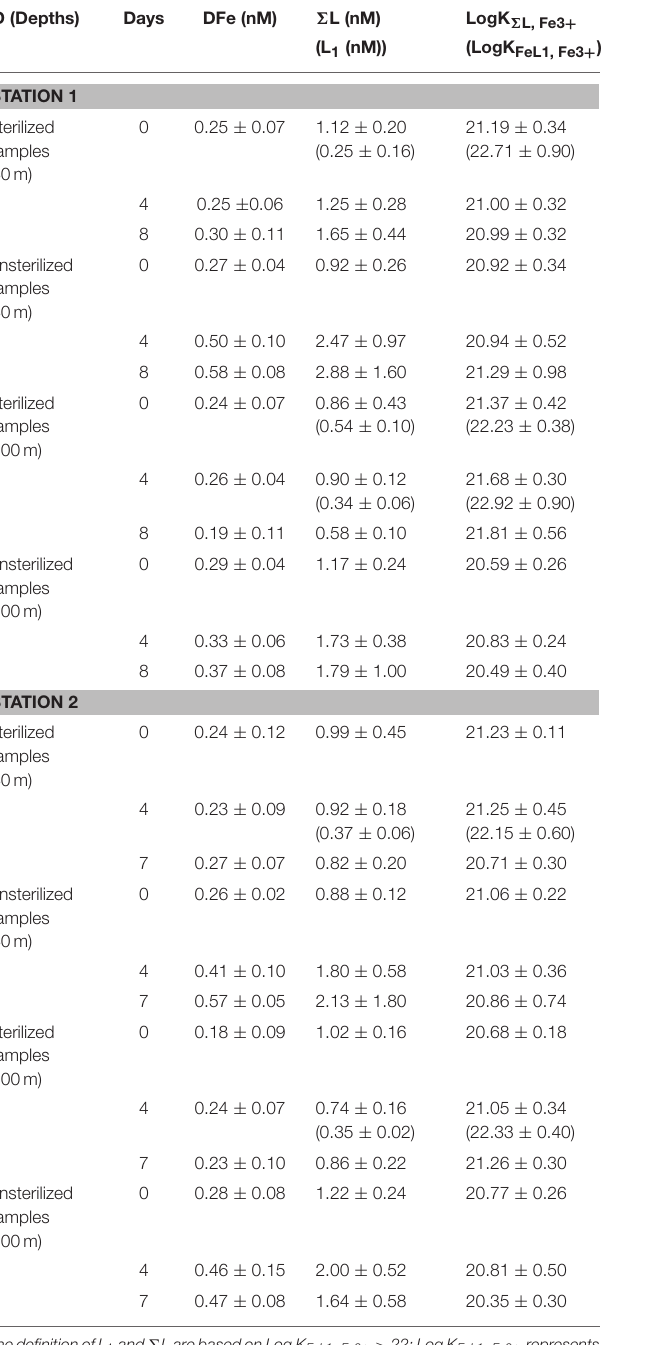
TABLE 1 | Iron speciation data showing the concentration of dissolved iron (DFe), sum of ligand ( 6 L) and L 1 , in brackets, and their conditional stability constants with respect to Fe 3 + (LogK FeL1, Fe3+ and Log K 6 L , Fe3+ ) observed during the remineralization experiments at 30 and 100m of station 1 and